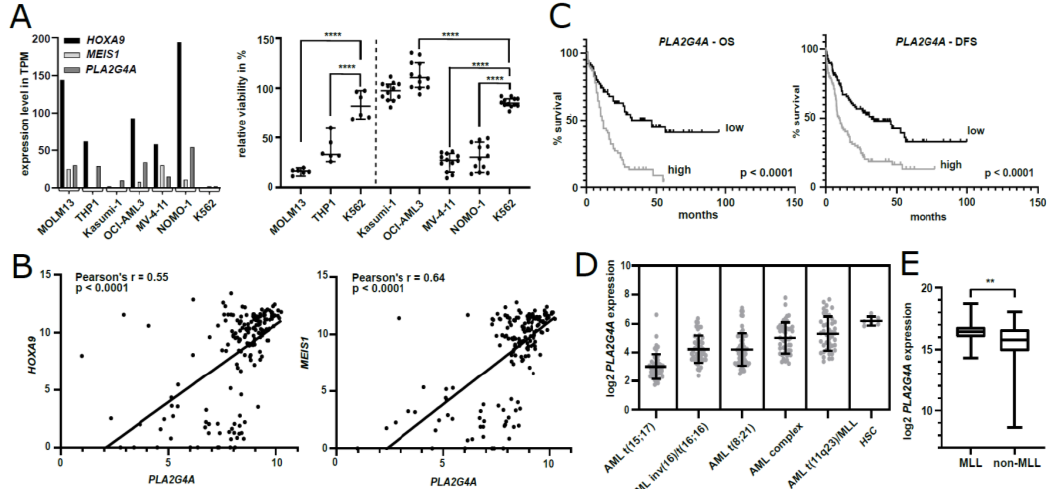
Figure 6. Characterization of PLA2G4A in human AML. ( A ) Left: expression levels of HOXA9 , MEIS1 , and PLA2G4A within MOLM13, THP1, Kasumi-1, OCI-AML3, MV-4-11, NOMO-1, and K562 cells based on RNA sequencing data from the Cancer Cell Line Repository. Right: alamarBlue viability assay of MOLM13, THP1, Kasumi-1, OCI-AML3, MV-4-11, NOMO-1, and K562 cells after 24 h exposure to 45 µ M AACOCF3 normalized to vehicle control-treated cells. The AML MLLr cell lines (MOLM13, MLL-AF9; THP1, MLL-AF9; MV4-11, MLL-AF4; and NOMO-1, MLL-AF9) showed a significant reduction in viability compared to the control K562 blast phase chronic myeloid leukemia cell line. Unrelated AML lines OCI-AML3 (wt. TP53 and NPM1c) and Kasumi-1 ((RUNX1/AML1-RUNX1T1/ETO) were not negatively impacted by the treatment. ****, p < 0.0001 with one-way ANOVA, Dunnett’s multiple comparison test. ( B ) Co-expression of PLA2G4A with HOXA9 (left) and MEIS1 (right), respectively, in AML samples from the TCGA-LAML data set. PLA2G4A expression significantly correlates with HOXA9 ( p < 0.0001, Pearson‘s r = 0.55) and MEIS1 ( p < 0.0001, Pearson‘s r = 0.64) (linear regression analysis). ( C ) Kaplan–Meier survival curve of overall survival (OS) and disease-free survival (DFS) in AML patients with above median PLA2G4A expression ( n = 61) compared to patients with below median PLA2G4A expression ( n = 60). The high PLA2G4A expression group had significantly lower OS (Mantel–Cox test: p < 0.0001, median OS = 12.2 months vs. 46.7 months) and DFS (Mantel–Cox test: p < 0.0001, median DFS = 9.6 vs. 32.3 months) compared to the control group. ( D ) PLA2G4A gene expression in patient samples with different AML subtypes and HSC of healthy individuals (scatter dot plot, mean ± SD: mean log2 PLA2G4A expression: AML t(15;17) = 3.0, AML inv[1 6]/t(16;16) = 4.2, AML t(8;21) = 4.2, AML complex = 5.0, AML t(11q23)/MLL = 5.3, HSC = 6.2). ( E ) Box plot of PLA2G4A expression in MLLr or non MLLr AML patient samples. The upper, center, and lower limit of each box denotes the upper quartile, median, and lower quartile, respectively. Whiskers representing min and max expression samples. PLA2G4A is significantly upregulated in AML patient samples with MLLr ( n = 30) compared to those without ( n = 142) (Welch‘s t -test: p = 0.0015, mean log2 PLA2G4A expression: MLL-AML = 16.34, non-MLL-AML = 15.67. TPM, transcripts per kilobase million. ** = p < 0.005; **** = p <